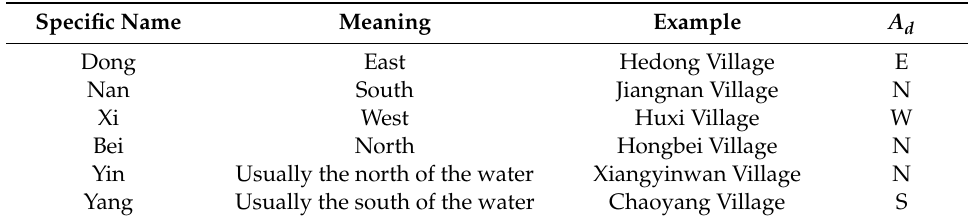
Table 2. Selected key words for direction in specific